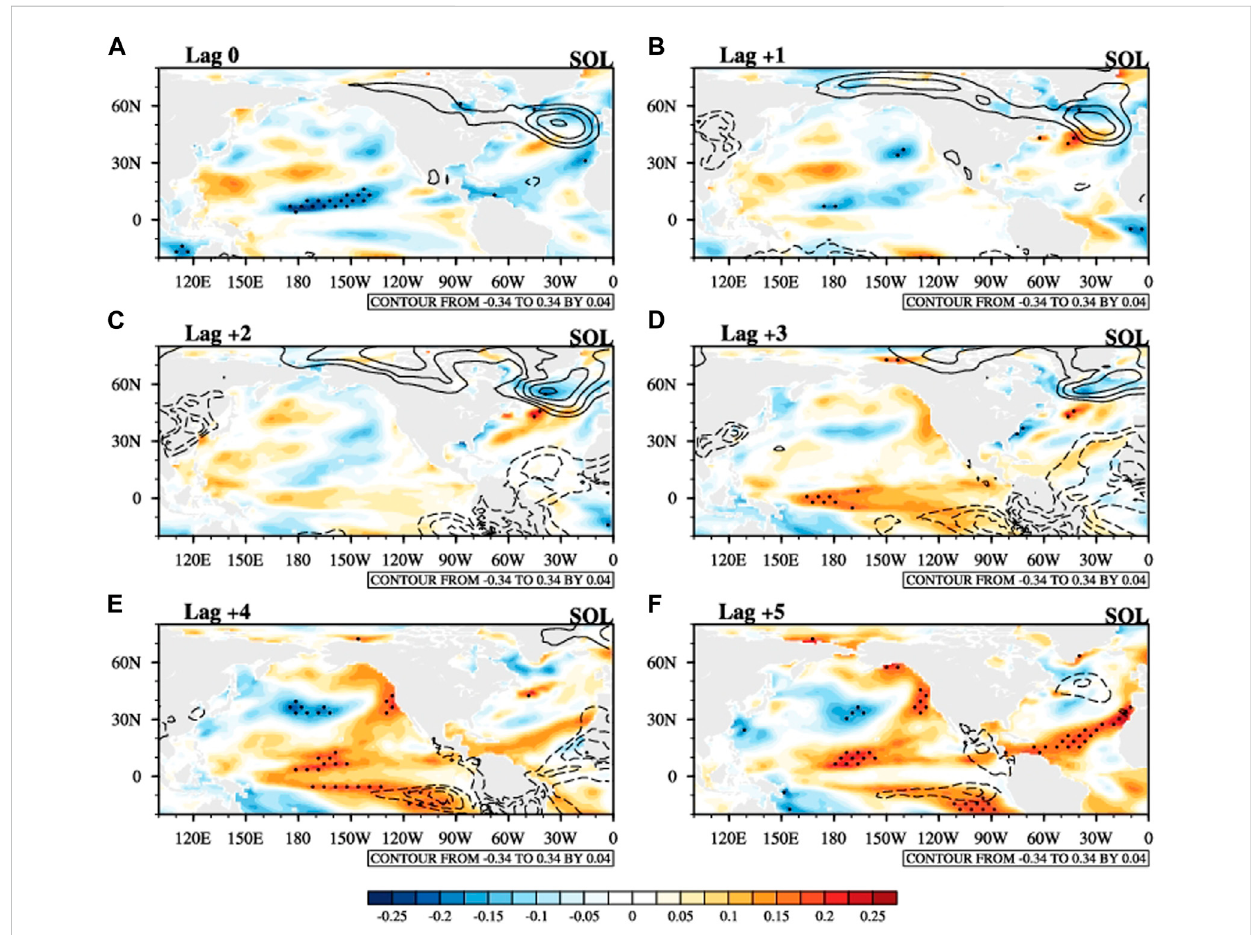
FIGURE 7 (A – F) Lagged correlation maps between the DJF-mean F10.7 index and the simulated DJF-mean SLP (contours) and JJA-mean SST (color shading contours) anomalies in the SOL experiment at the lag of 0 – 5 years. The black dotted regions of the color shading contours indicate above the 90% signi fi cance level. The contour interval for the SLP anomaly is 0.04 and only the values above the 90% con fi dence level are